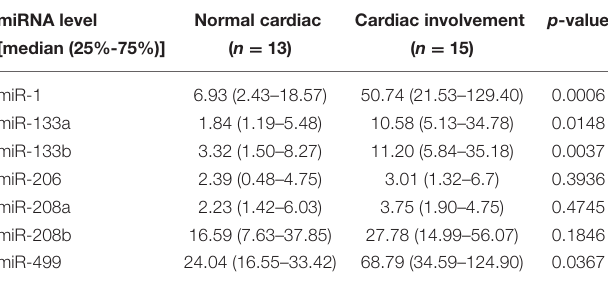
TABLE 7 | Comparison of serum miRNA levels in DMD patients with cardiac involvement or non-cardiac-involved patients. miRNA level Normal cardiac Cardiac involvement p -value [median (25%-75%)]